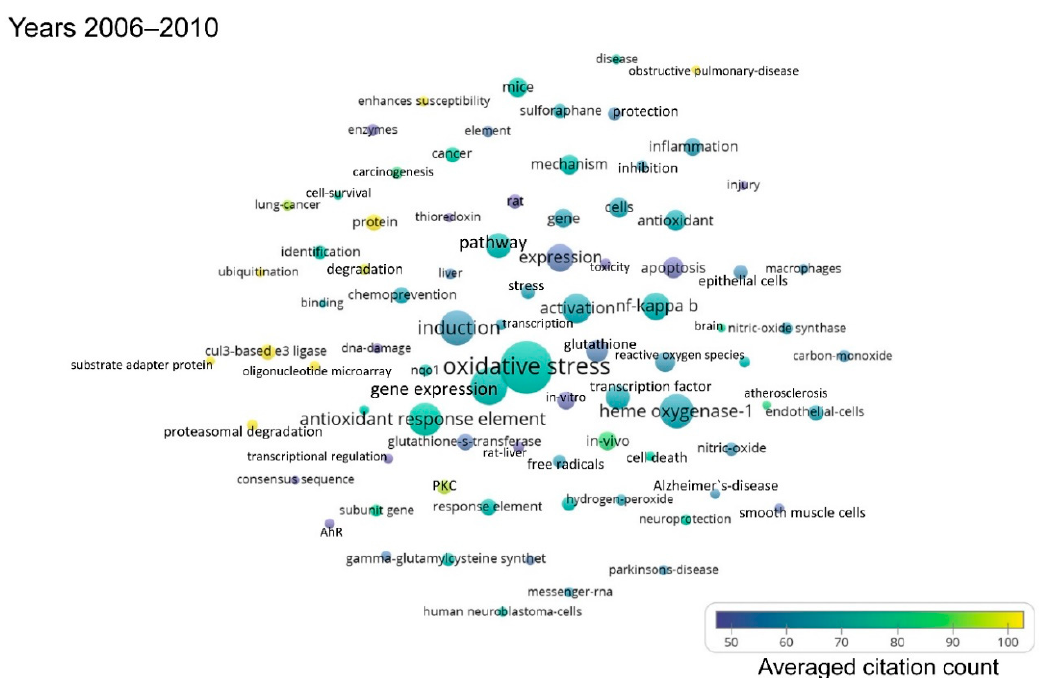
Figure 3. Term map for years 2006–2010. Bubble map showing the visualization of 83 terms that appeared in at least 20 publications published between 2006 and 2010. For explanations on bubble size, color and proximity, see the legend of Figure 2. All the terms visualized are listed in Table S2, along with their respective occurrence frequencies and averaged citations. AhR: Aryl hydrocarbon receptor, PKC: Protein kinase C.